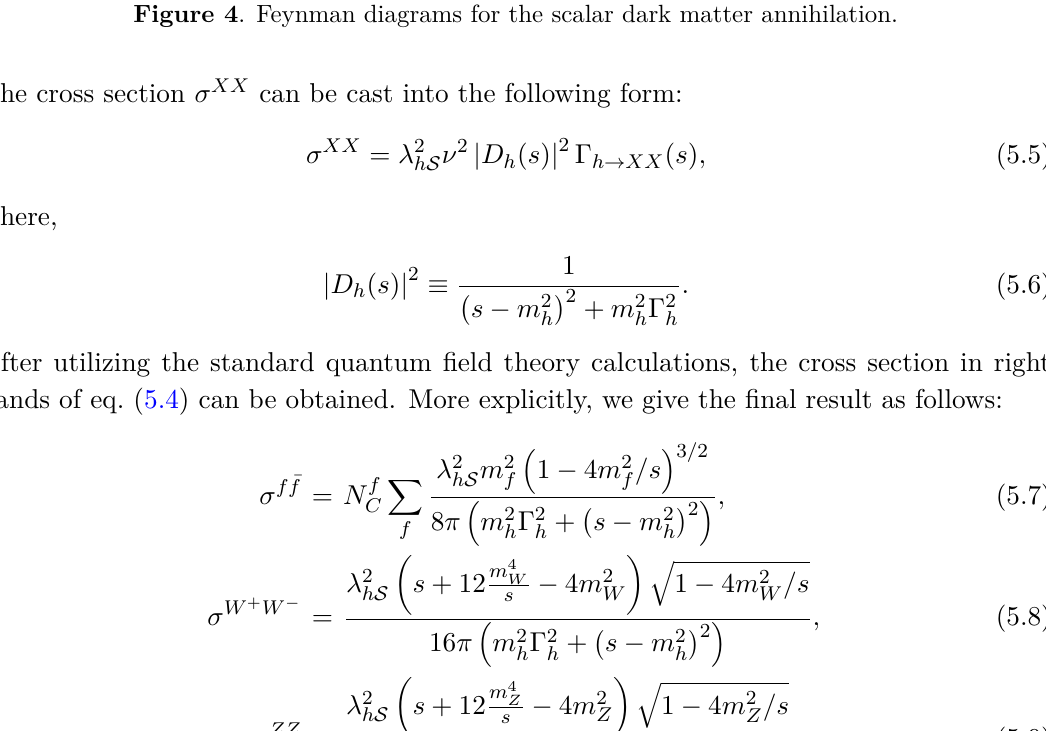
Figure 4 . Feynman diagrams for the scalar dark matter